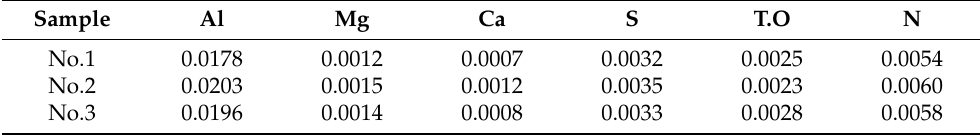
Table 3. Chemical compositions of the three groups of samples (weight